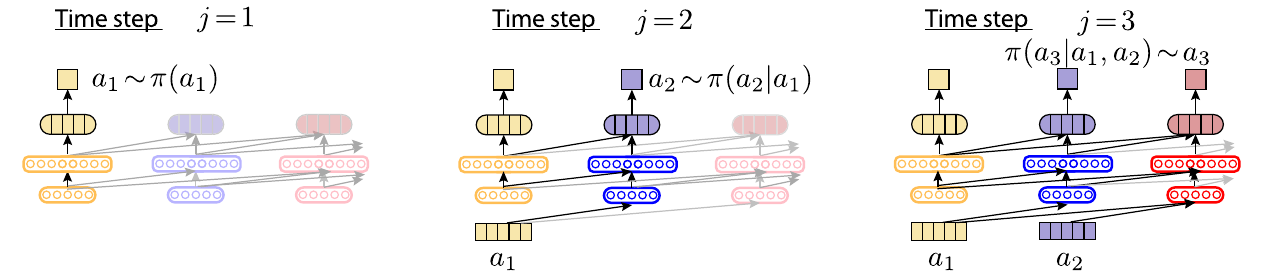
FIG. 10. Exact sampling algorithm for CD-QAOA with an autoregressive policy network, where faded nodes and connections represent unused nodes and connections. The action at each time step is generated sequentially by computing its respective conditional categorical distribution and sampling according to that. Notice that only a single column is processed at each time step, and in order to sample a complete sequence of actions in an episode, one needs to make a forward pass through the network architecture q times.